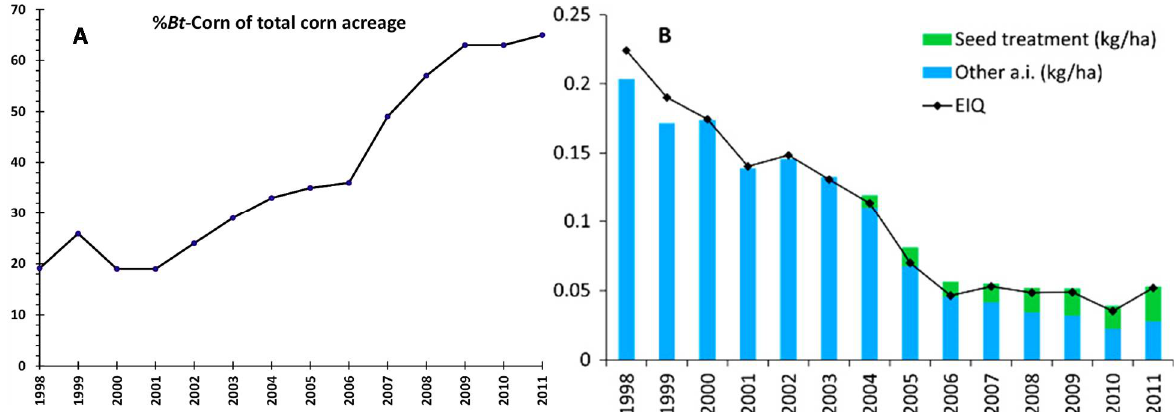
Figure 1. Insect resistant Bt -corn decreased pesticide use in US. ( A ) Percentage of Bt -corn acreage out of total corn planted between 1998 and 2011 (data extracted from [13]). ( B ) Insecticide use in maize (kg/ha and environmental impact quotient (EIQ) weights) during the same period as in A. (Figure reproduced from [14].)